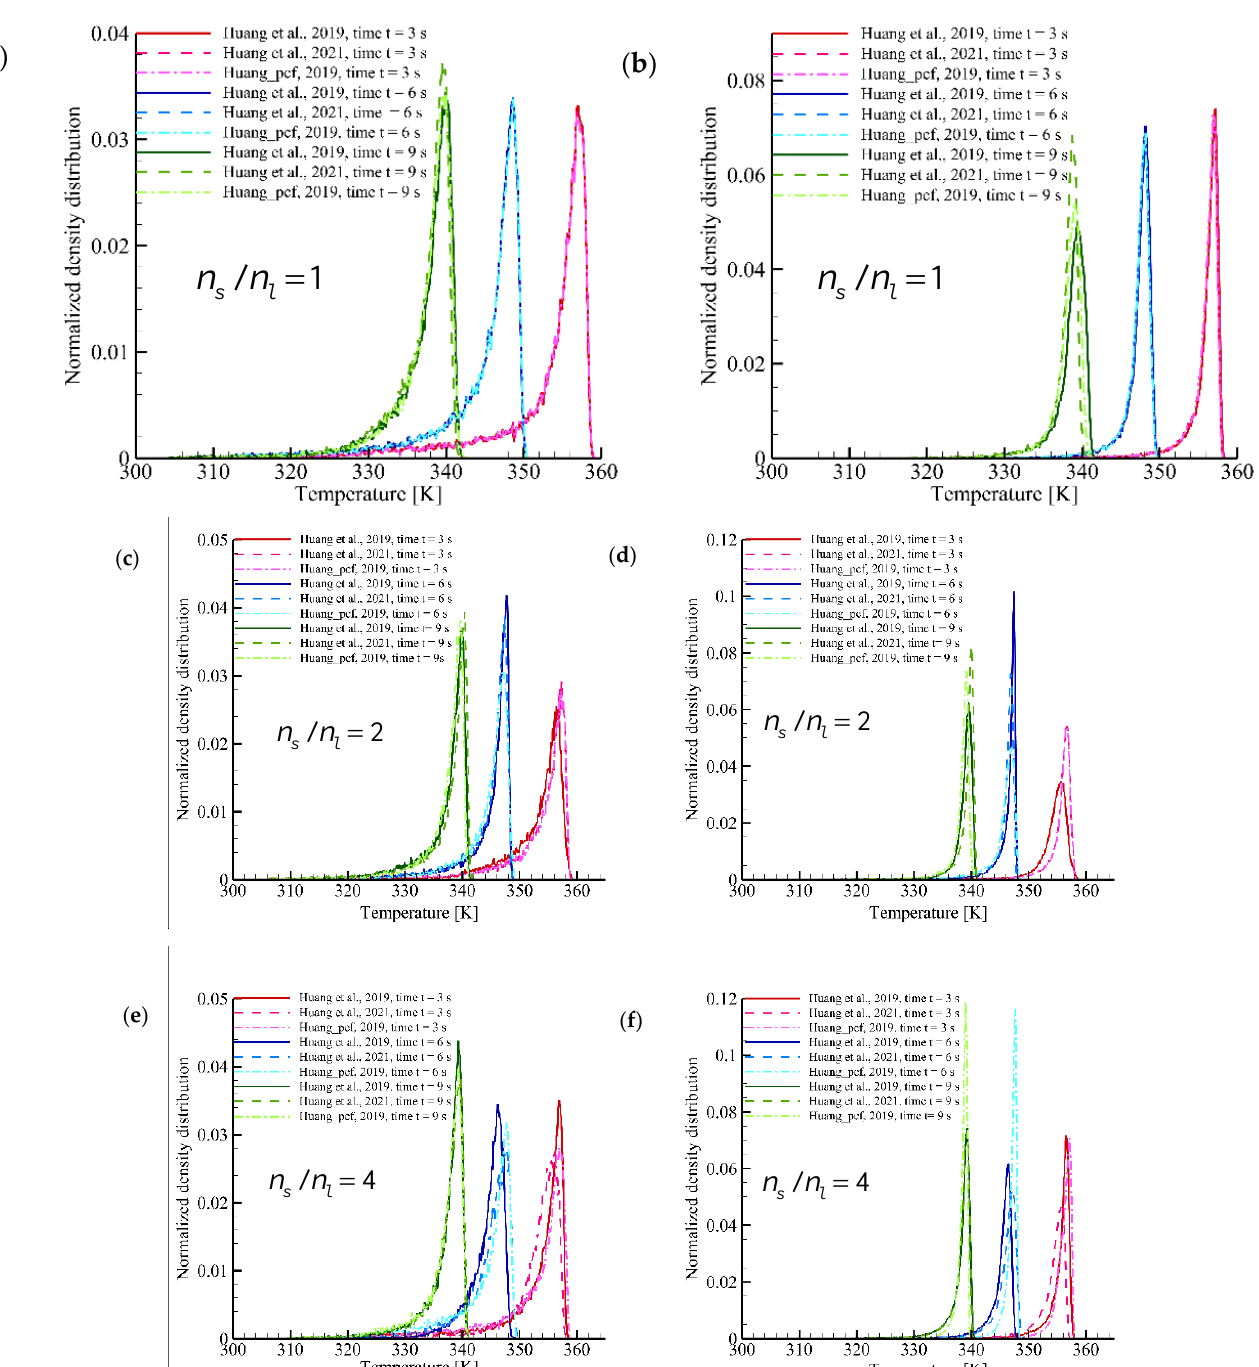
Figure 7. Particle temperature distribution profile: ( a , c , e ) large particles; ( b , d , f ) small particles. Huang et al., 2019 [9], Huang et al., 2021